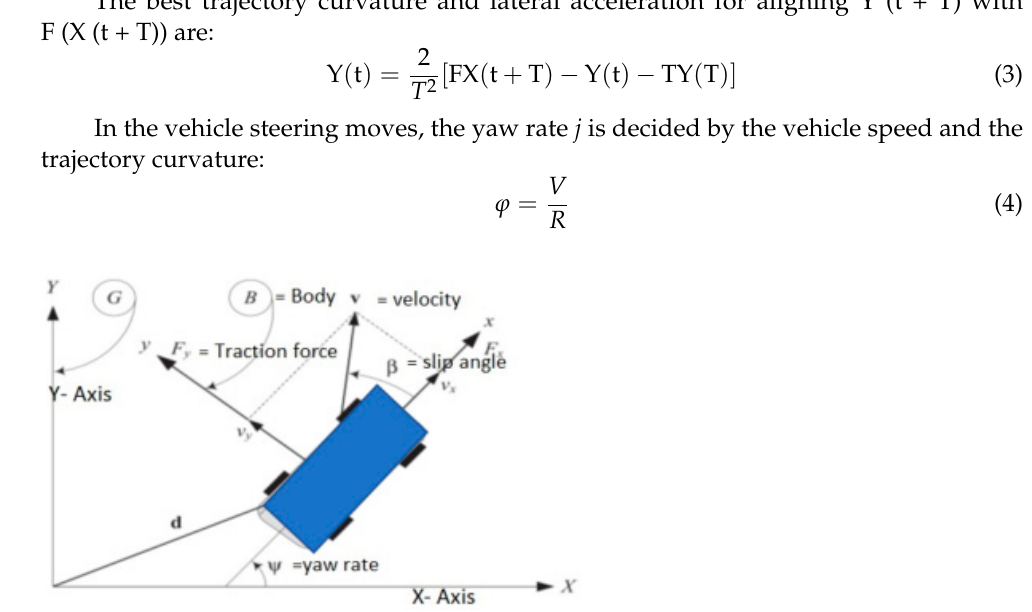
Figure 5. Forces acting on a vehicle when travelling on clothoid road. Adopted and modified from [23].